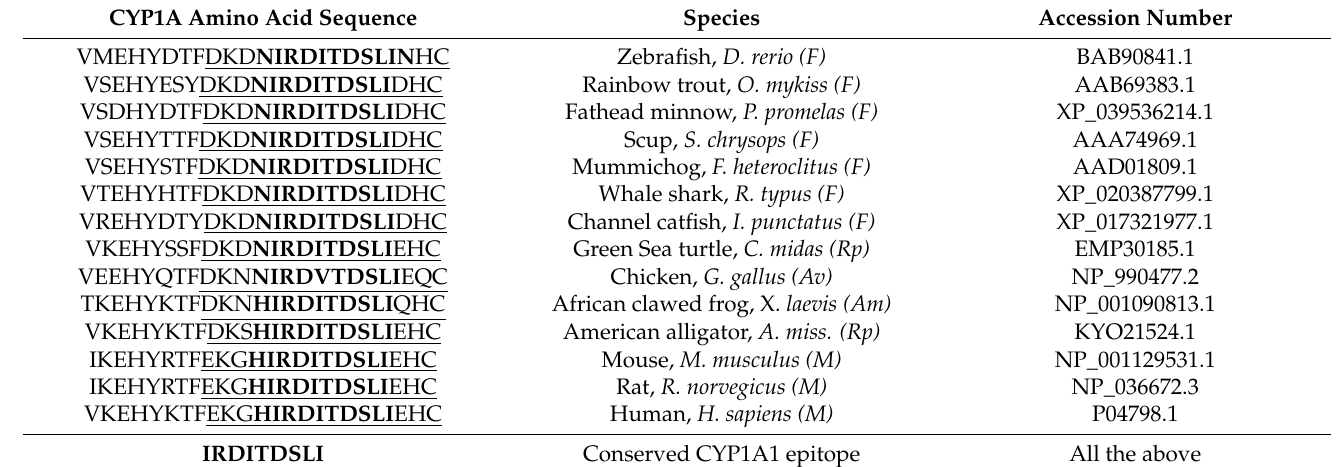
Table 1. Amino acid sequence of predicted most immunogenic CYP1A peptides (underlined) from representative vertebrates (F, fish; Rp, reptile; Avian, Av; Mammal, M) demonstrating a highly conserved core CYP1A1 epitope (IRDITDSLI). Mice were immunized with synthetic zebrafish CYP1A peptide conjugated to KLH at the C-terminus cysteine (C) and resulting hybridomas screened against the unconjugated peptide by ELISA. Positive hybridomas were subsequently re-screened by ELISA against the core sequence (IRDITDSLI) to obtain mAb CRC4 with reactivity across vertebrate taxa.